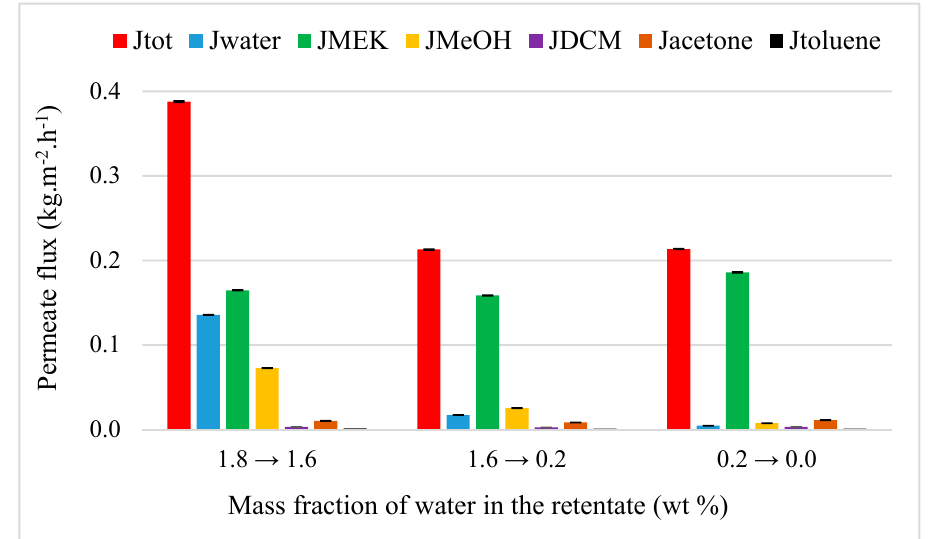
Figure 11. Evolution of flux as the function of the inlet water composition from a quaternary MEK-water–MeOH-DCM mixture (90.6/5.6/1.9/1.9 wt%) through M1 at 50 °C.